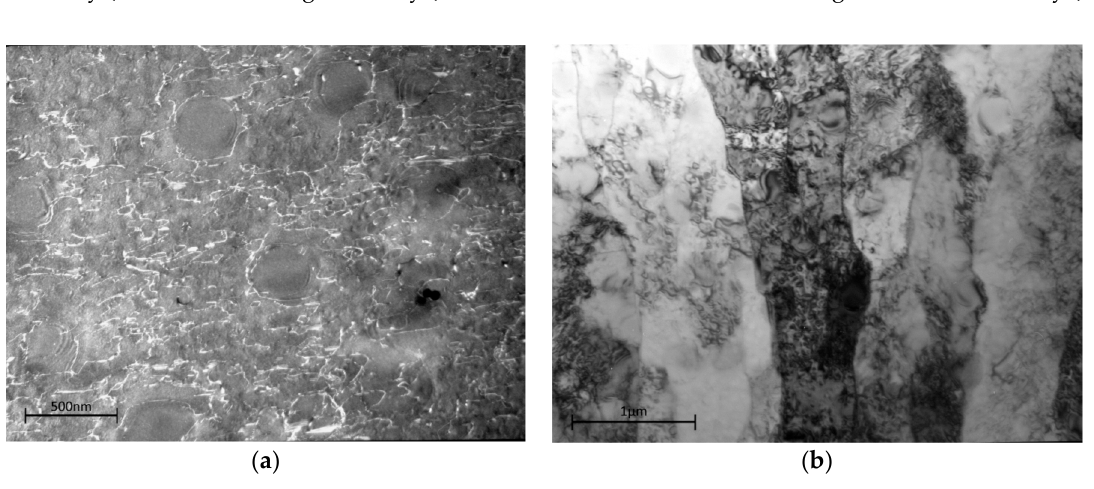
Figure 11. Dislocation structure in Waspaloy subjected to creep loading at 500 MPa in the ( a ) weak beam image of the interior of a grain; ( b ) bright field image of the grain boundary zone.